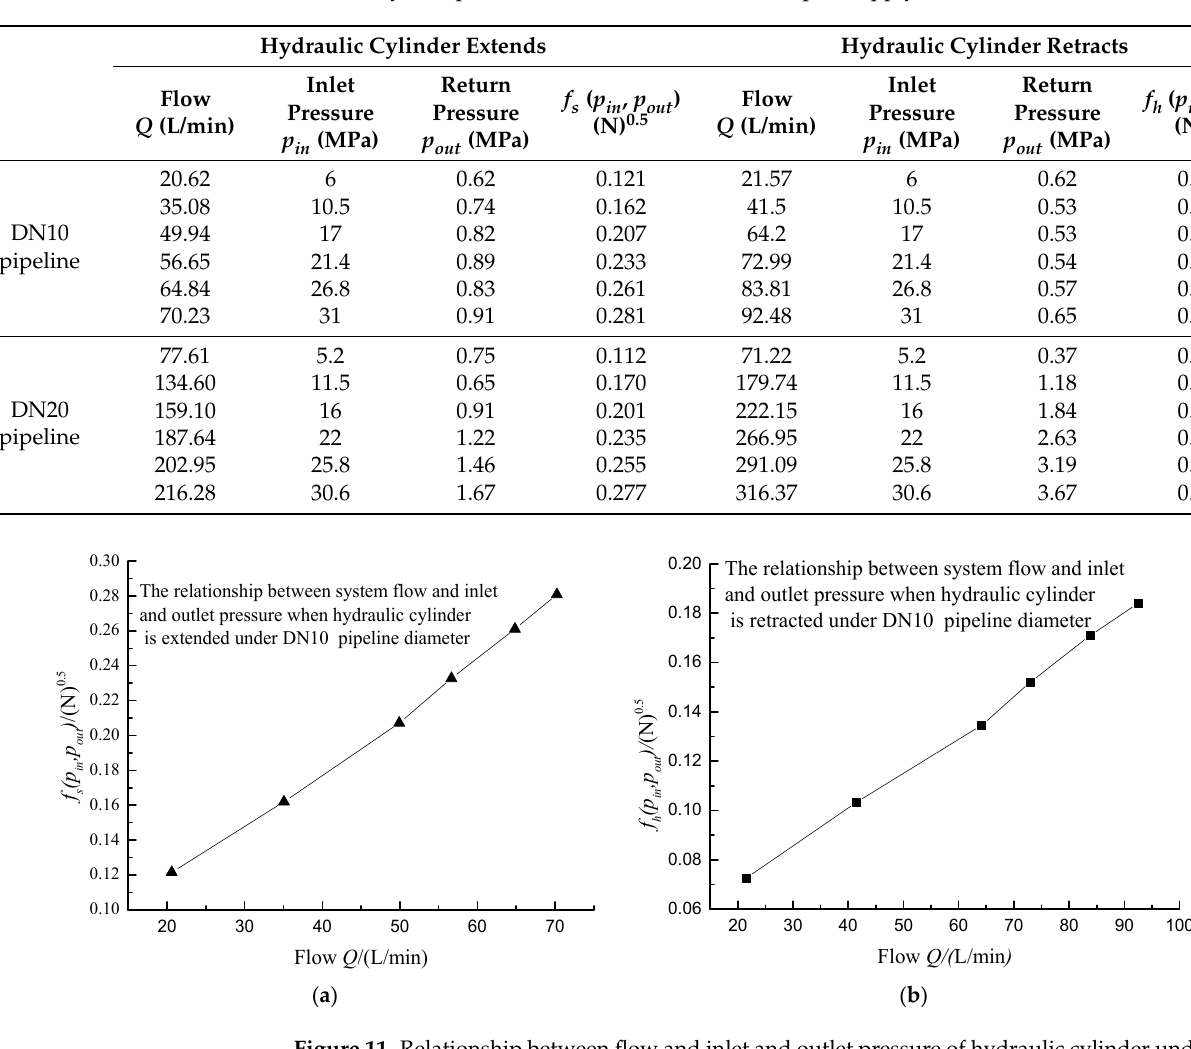
Table 7. System parameters table under different liquid supply conditions.